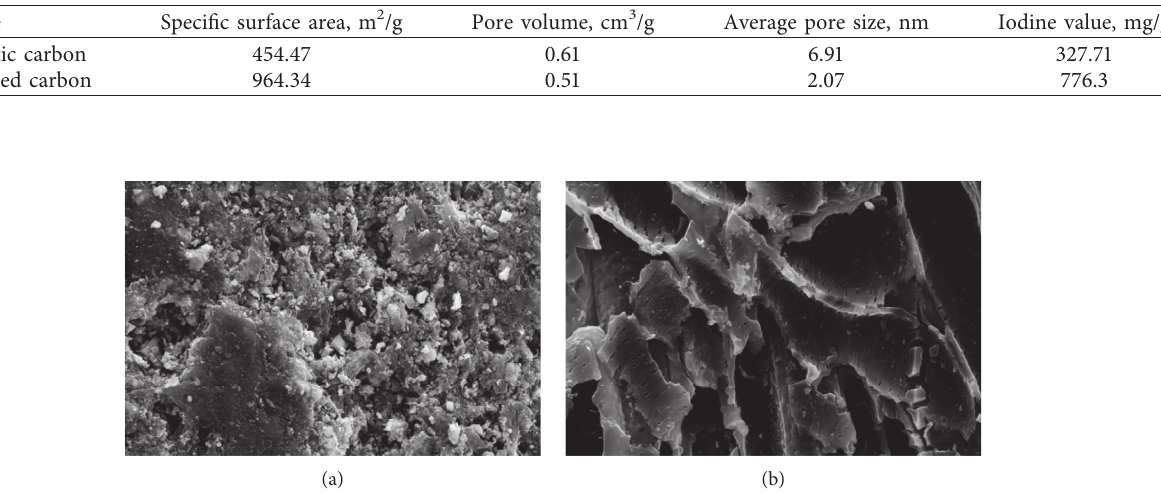
Table 5: Surface characteristics and iodine value of pyrolytic carbon and activated